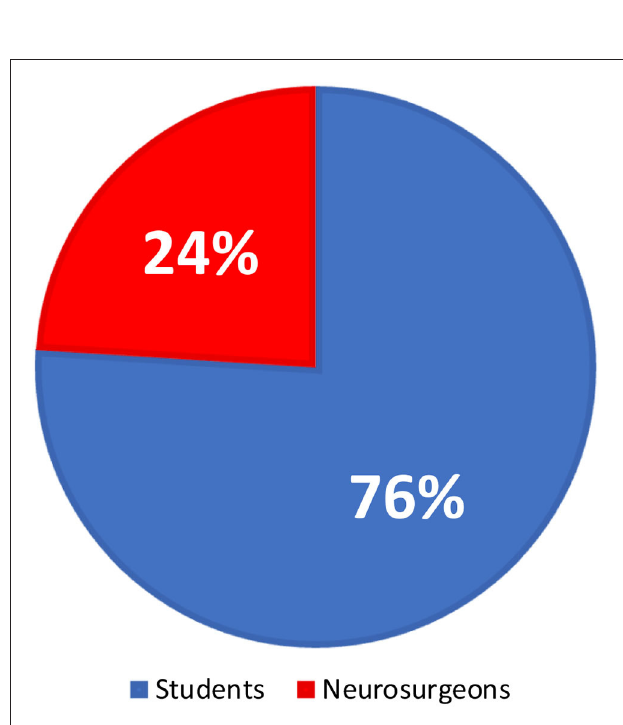
FIGURE 1 | Examples for GNS-I study team structures with maximum student representation in the same center.